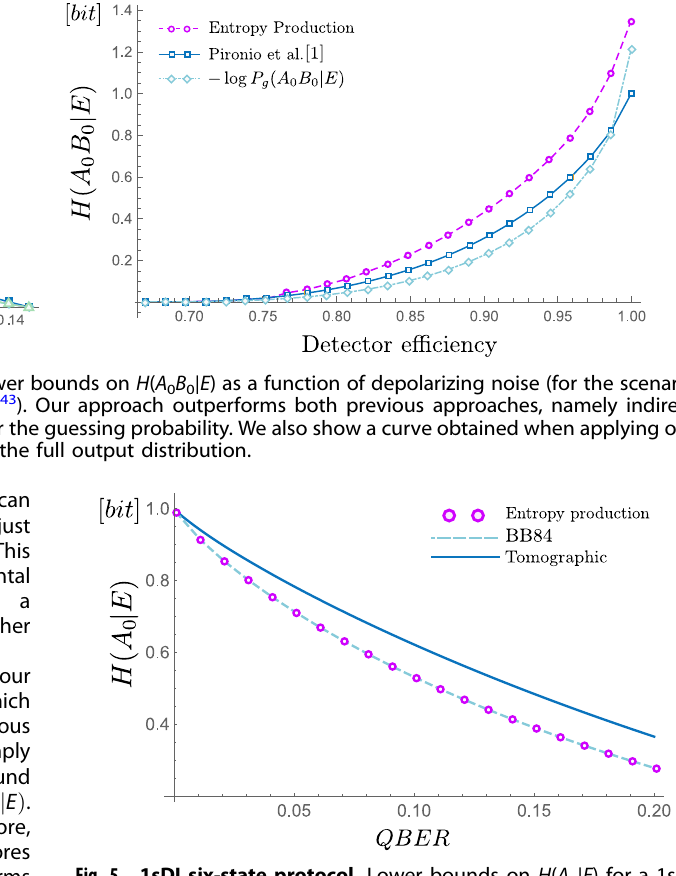
Fig. 5 1sDI six-state protocol. Lower bounds on H ( A 0 ∣ E ) for a 1sDI version of the six-state protocol 50 . Interestingly, the bound we obtain from our method coincides with that for the BB84 protocol. For reference, we also show the bound that could be obtained from a tomographically complete characterization of the state, such as via the measurements in the standard (device-dependent) six-state